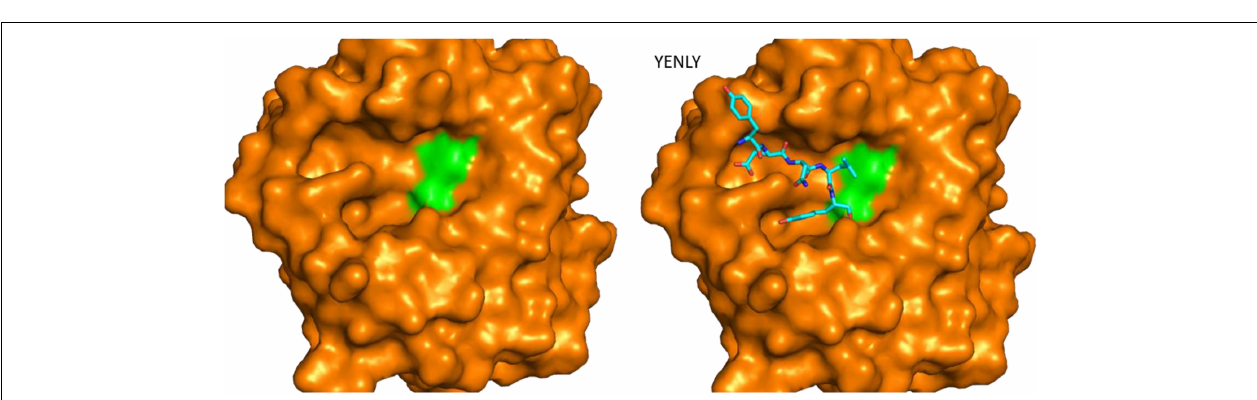
FIGURE 4 | Structure of rMtaKer and its insights into protease and substrate interactions. Surface presentation of one keratinase in the absence and presence of a peptide sequence binding to the active site. The crystal structure of the protease (PDB ID 5WSL) is shown (Wu et al., 2017). The orientation of the figure is similar to those in Figure 3 . The residues forming the catalytic triad are shown in green, and the peptide from the adjacent molecule in the crystal structure is shown in sticks. The peptide sequence is shown as sticks in the